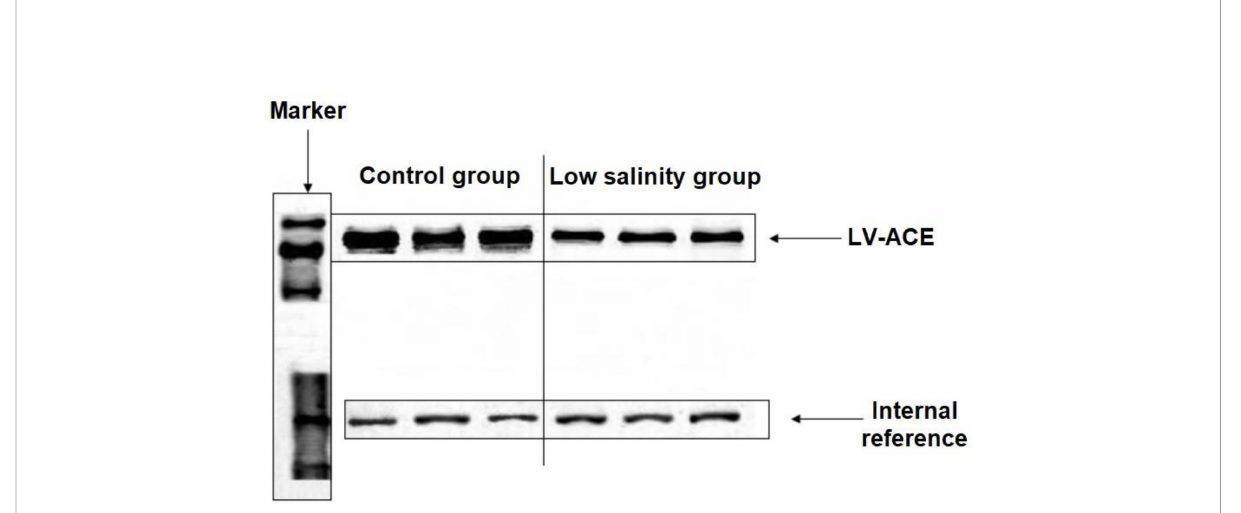
FIGURE 10 Western blot results of the expression of LV-ACE protein in the hepatopancreas under long-term low salinity and the control group. GAPDH was used as an internal